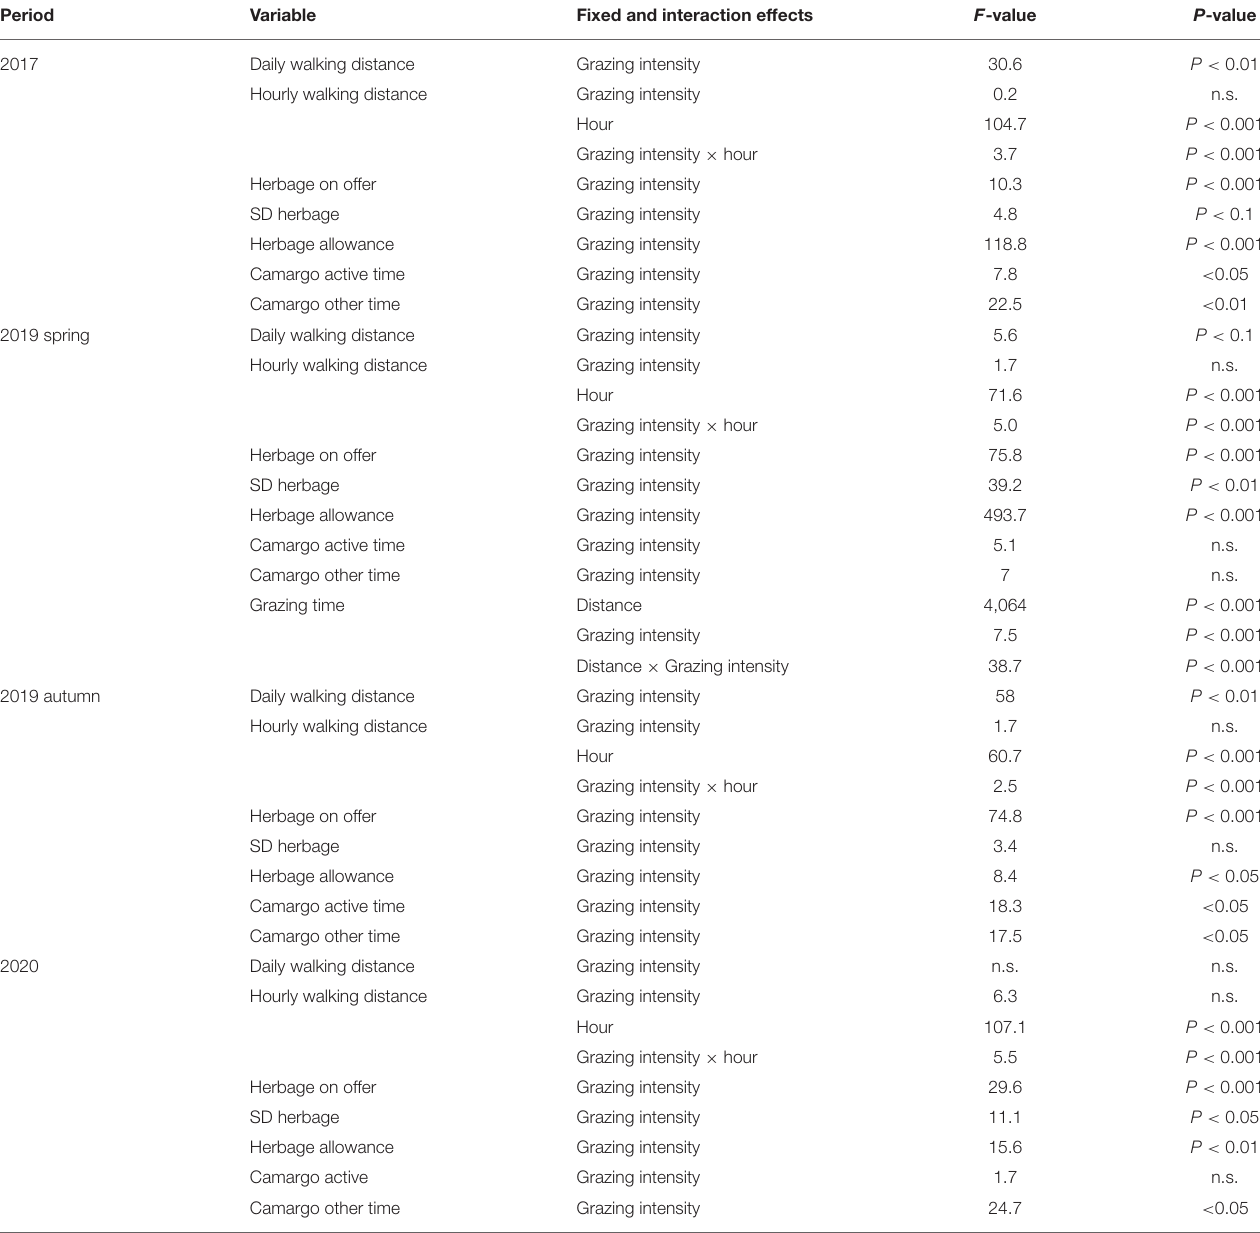
TABLE 3 | Output of linear mixed effects models for the analyzed parameters of interest during each grazing period.